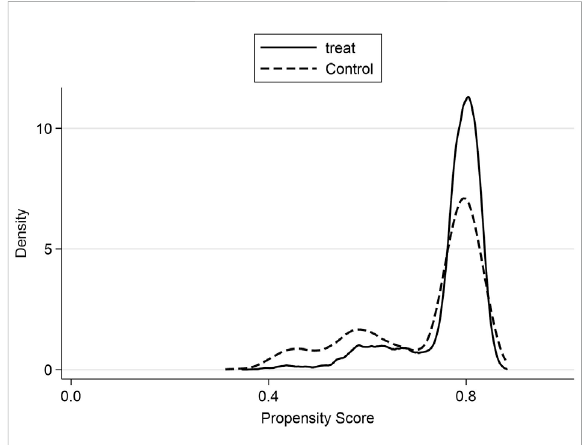
FIGURE 1 Propensity score — probability density plot (before